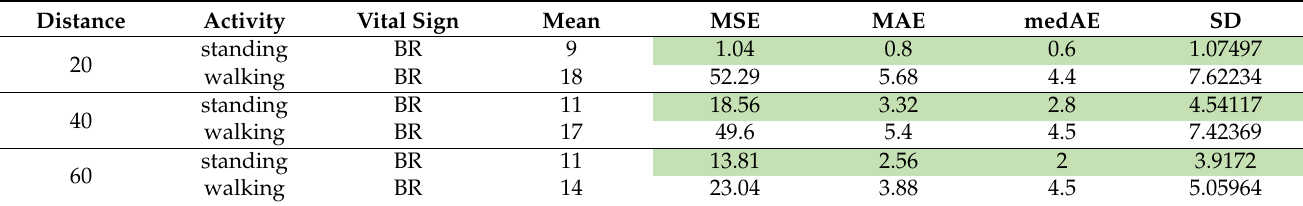
Table 7. Performance analysis of breathing rate (with and without moving).